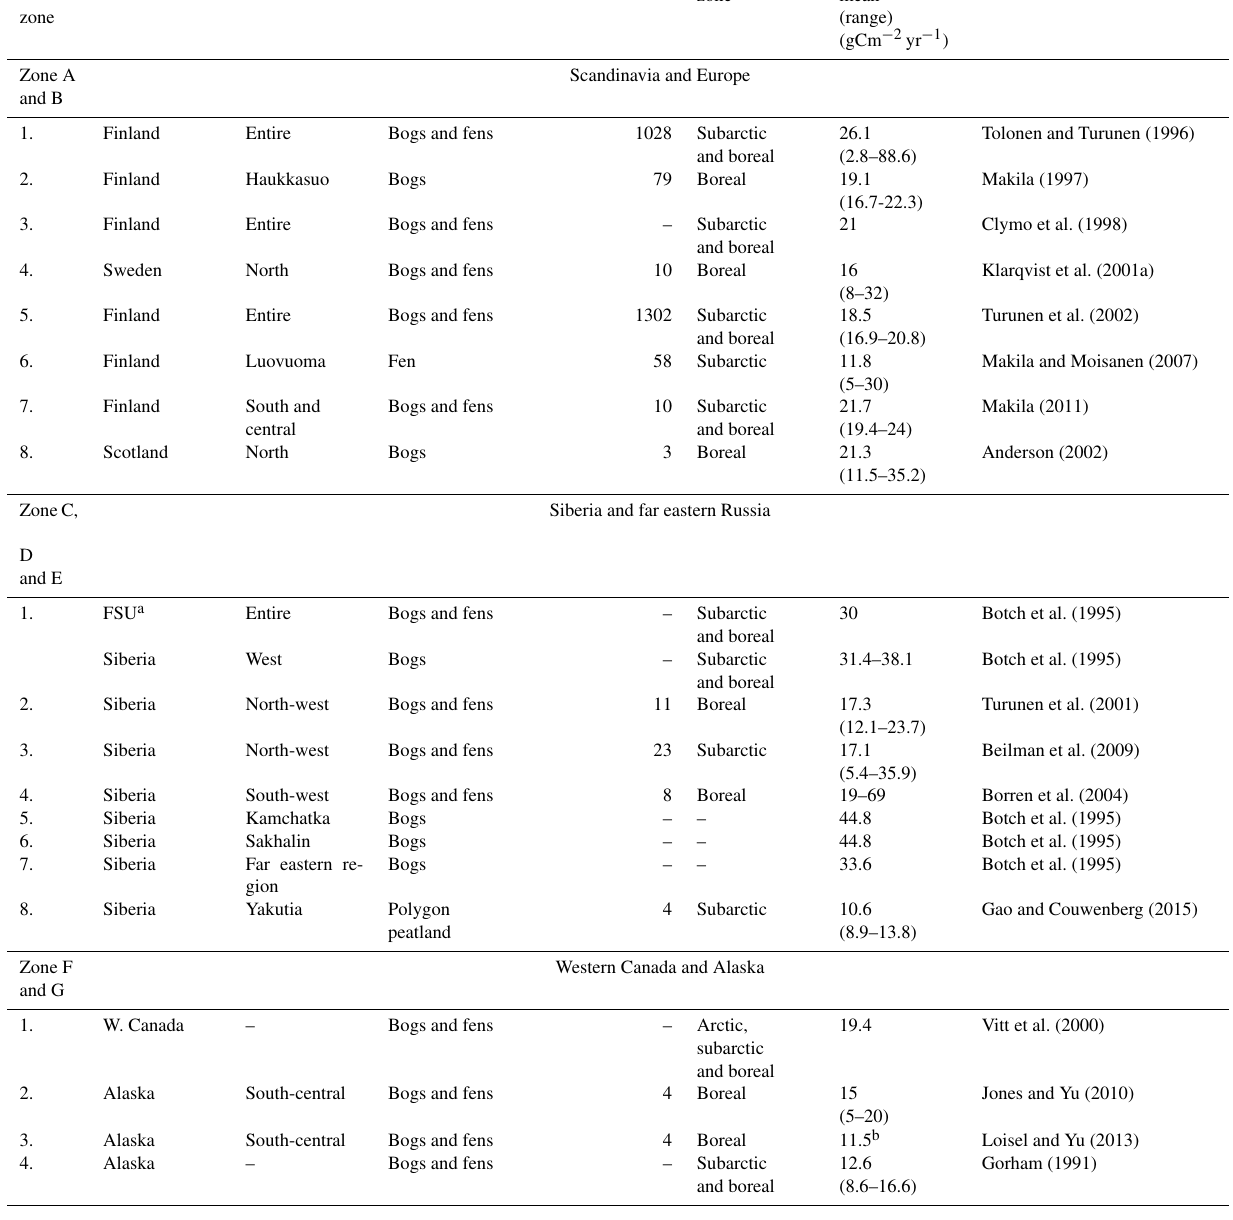
Table 3. Observed regional long-term rate of peatland C accumulation across northern latitude areas.